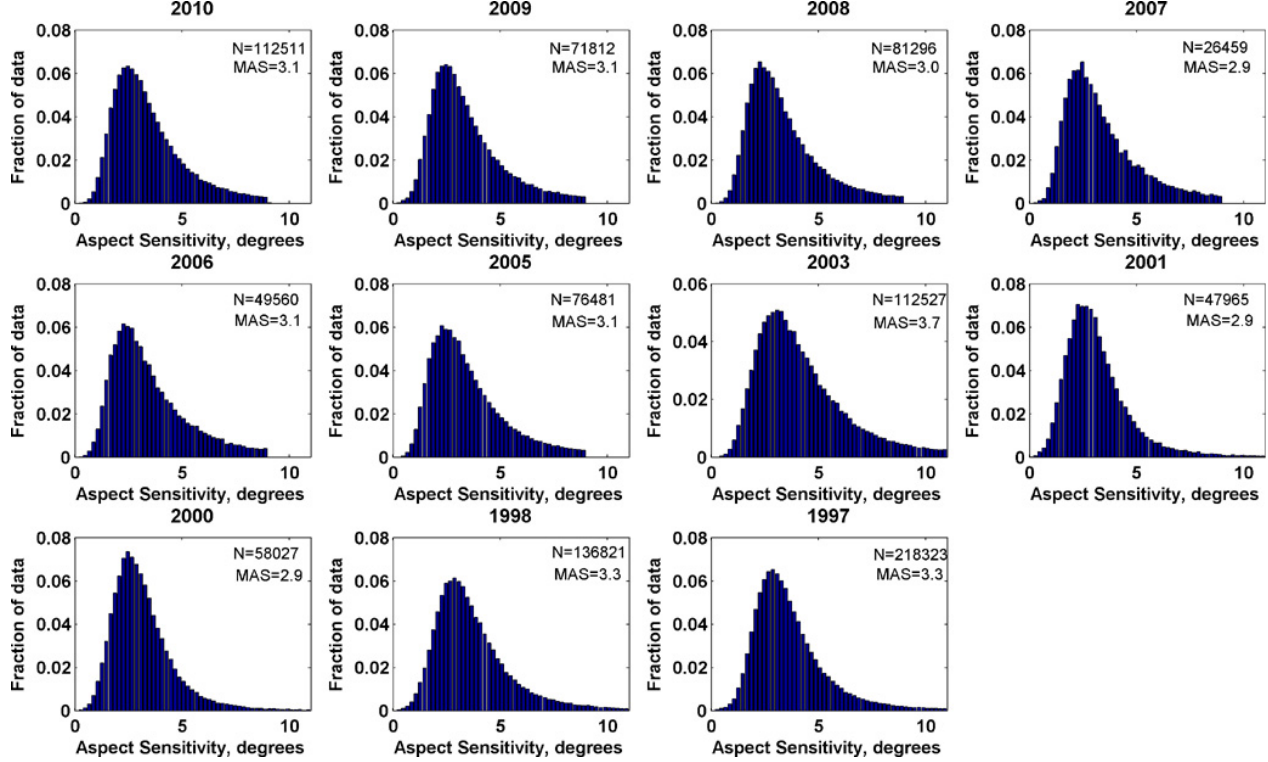
Fig. 3. The distributions of aspect sensitivity parameter for different years. N is the total number of data points, MAS is the median aspect sensitivity parameter in degrees.